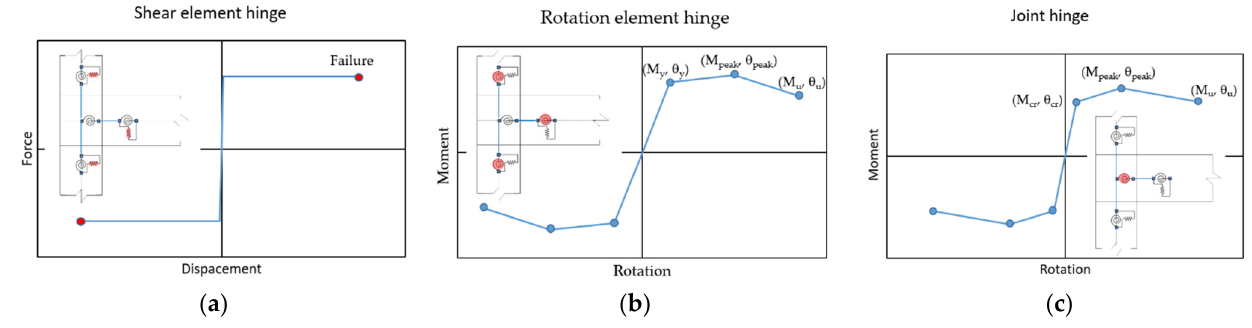
Figure 4. Non-linear behavior adopted in the FE models. ( a ) Zero-length elements at the extremities of beams and columns; ( b ) Plastic hinges at the extremities of beams and columns; ( c ) Zero-length elements simulating the non-linear behavior of the joint panels.